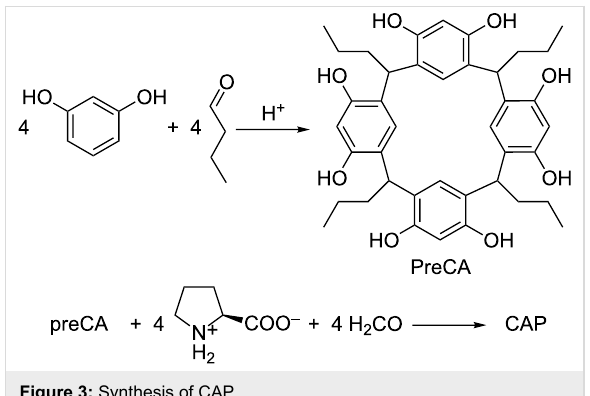
Figure 3: Synthesis of